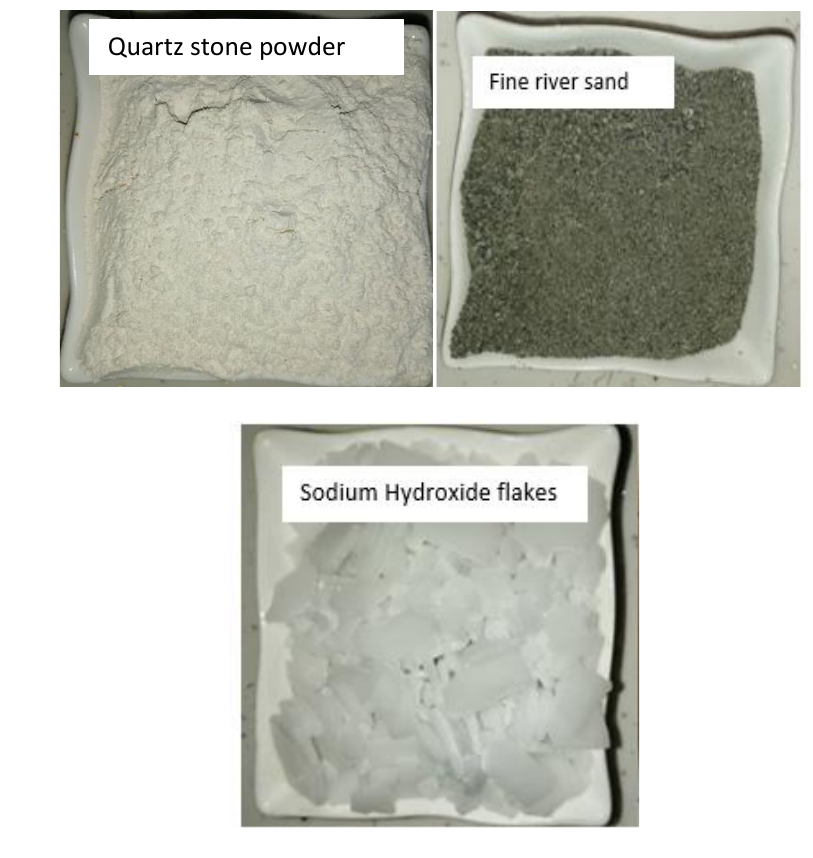
Fig. 2. Materials used in this